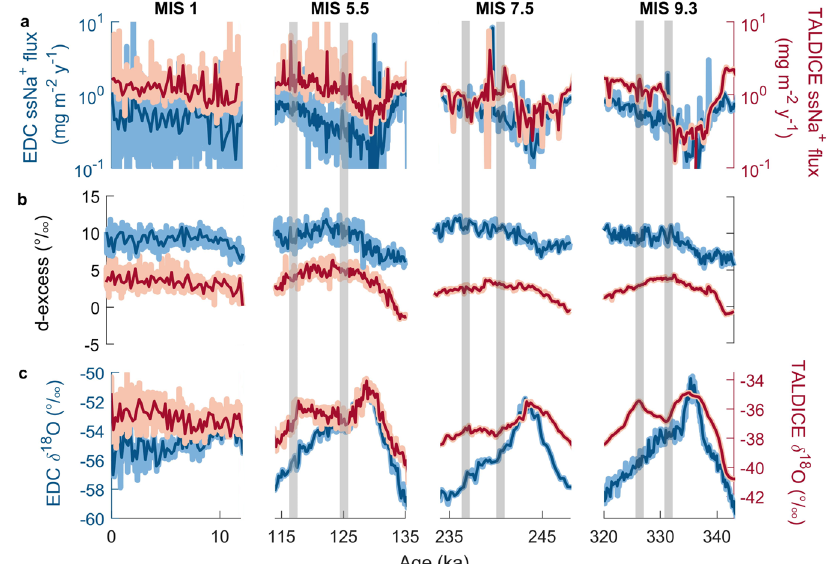
fl uxesforMarineIsotopicStage(MIS)7.5and9.3arefromthisstudy. b EDC 41 and TALDICE 28 d-excess records. TALDICE d-excess records for MIS 5.5, 7.5, and 9.3 arefromthisstudy. c EDC 36,37,41 andTALDICE 30,34 δ 18 Orecords.TALDICE δ 18 Odata forMIS7.5and9.3arefromthisstudy.TheanomaliesintheTALDICE δ 18 Orecord are identi fi ed by grey shaded bars (marking the start and end of the anomalous increase in δ 18 O